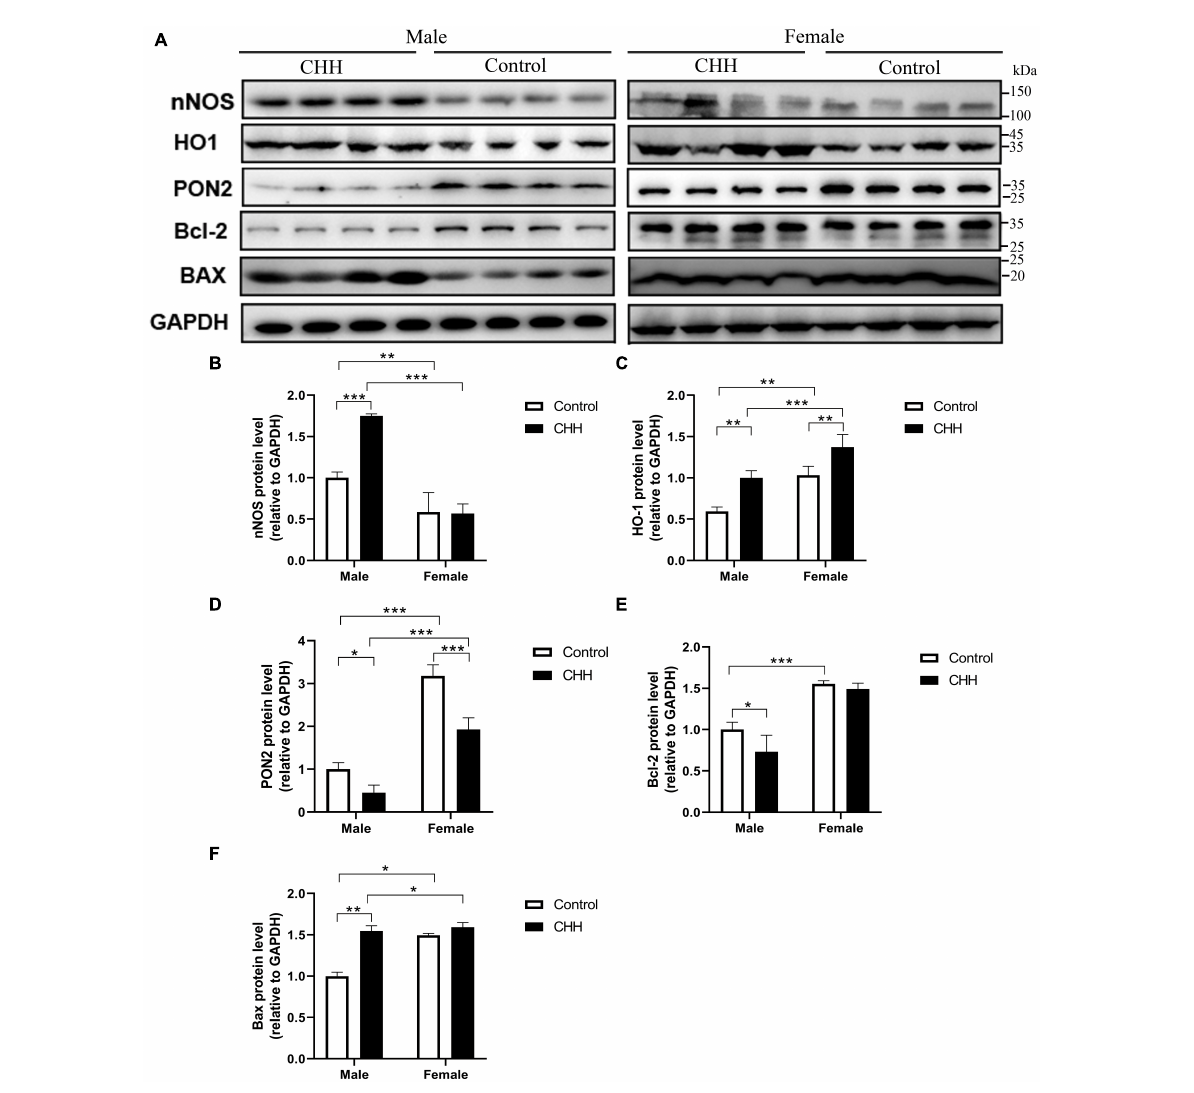
FIGURE9 Effects of CHH exposure on the levels of the following signaling proteins from the hippocampus of male and female rats: nNOS, HO-1, PON2, Bcl-2, and Bax. The signaling proteins were measured by immunoblot analysis and were normalized to GAPDH as a reference protein in the hippocampus. Data are reported as fold induction relative to the male control group for male rats. Representative bands are shown on the top panel (A) . Representative Western blots of results shown for (B) nNOS, (C) HO-1, (D) PON2, (E) Bcl-2, and (F) Bax in the hippocampus. Values are means ± SD for four animals/group. Data for male and female rats, with or without CHH exposure, were analyzed using two-way ANOVA. Post hoc analysis indicated: * p < 0.05, ** p < 0.01, *** p <